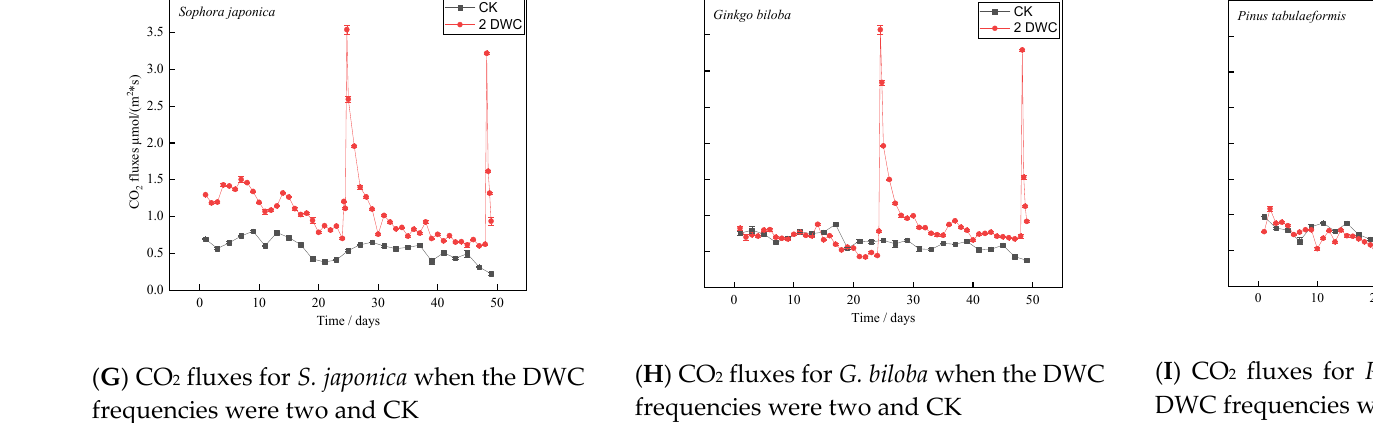
Figure 2. Effects of DWC frequencies on soil CO 2 fluxes.